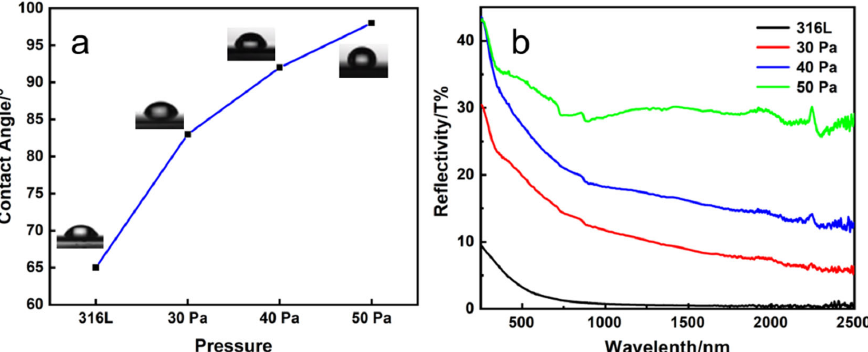
Figure 7. ( a ) Surface water contact angle and ( b ) UV reflectance of Nb ‐ Zr alloying layers prepared at pressures of 30 Pa, 40 Pa, and 50 Pa.